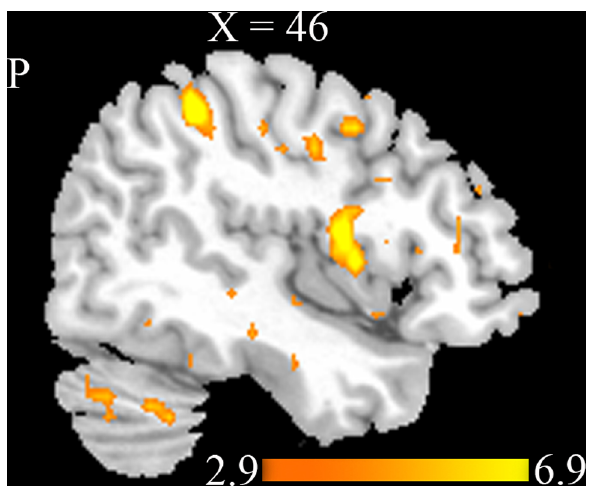
Figure 4. Brain areas showed significant main effect of group at p , 0.001 (uncorrected, cluster size . 30 voxels) with increased ReHo values in MCI patients compared with normal controls. Warm colors indicate the significantly increased ReHo values.